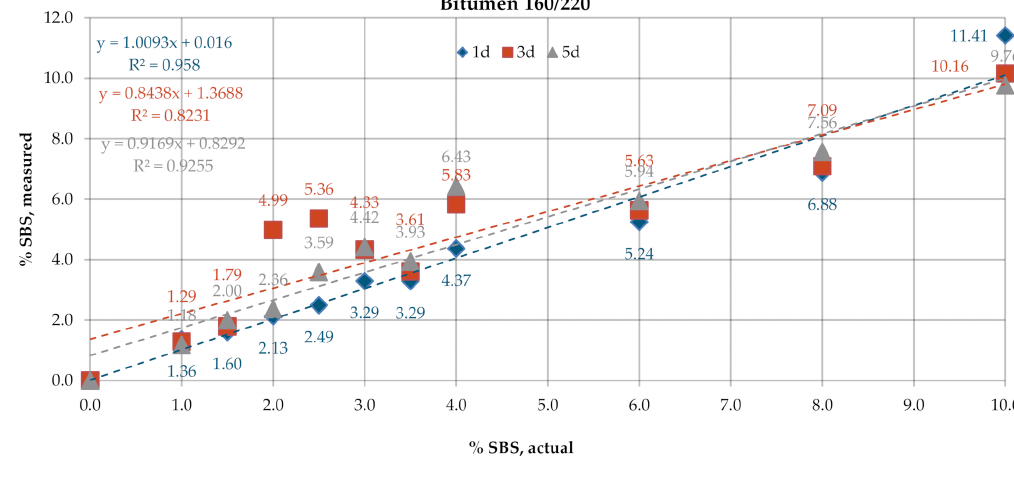
Figure 12. SBS contents in the samples of bitumen 160 / 220.